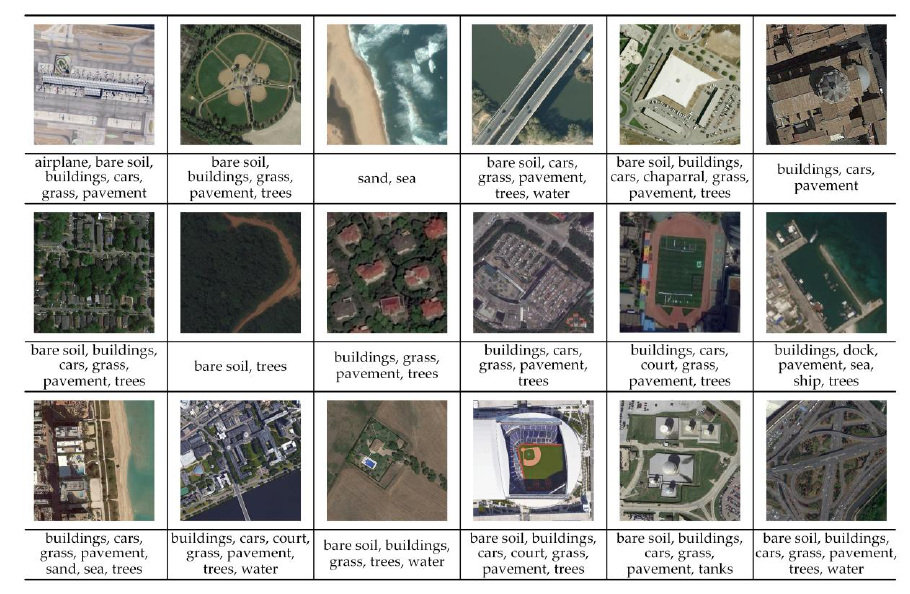
Figure 3. Samples in the AID multi-label dataset.